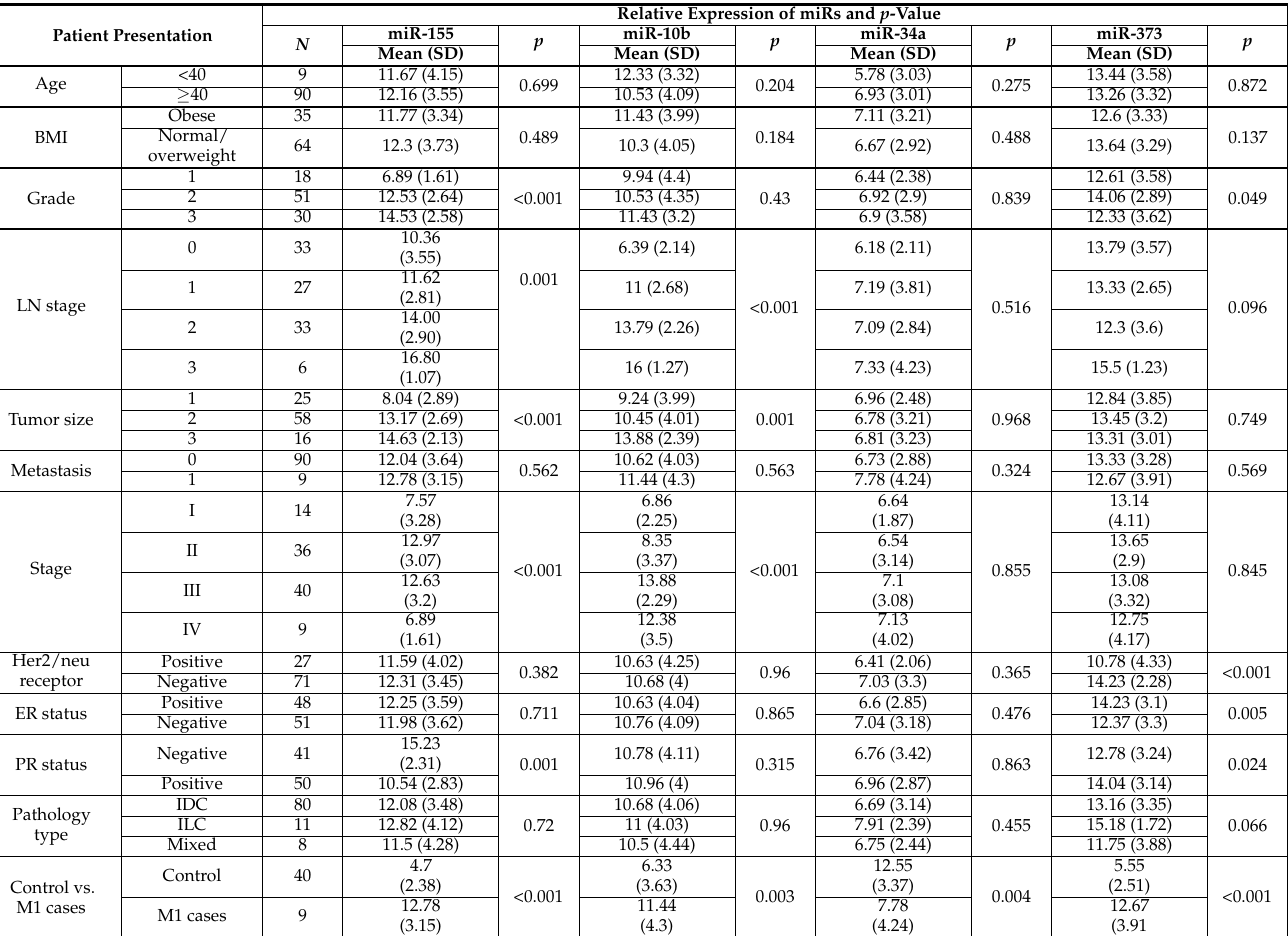
Table 1. Correlation between FCs of miR-155, miR-10b, miR-34a, and miR-373 and clinicopathological data of BC